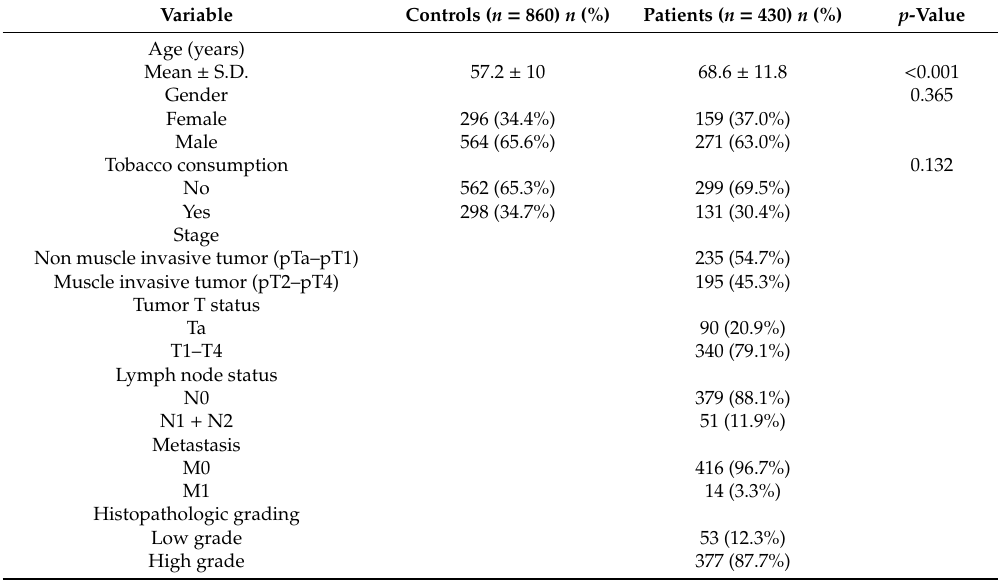
Table 1. The distributions of demographical characteristics in 860 controls and 430 patients with urothelial cell carcinoma (UCC).